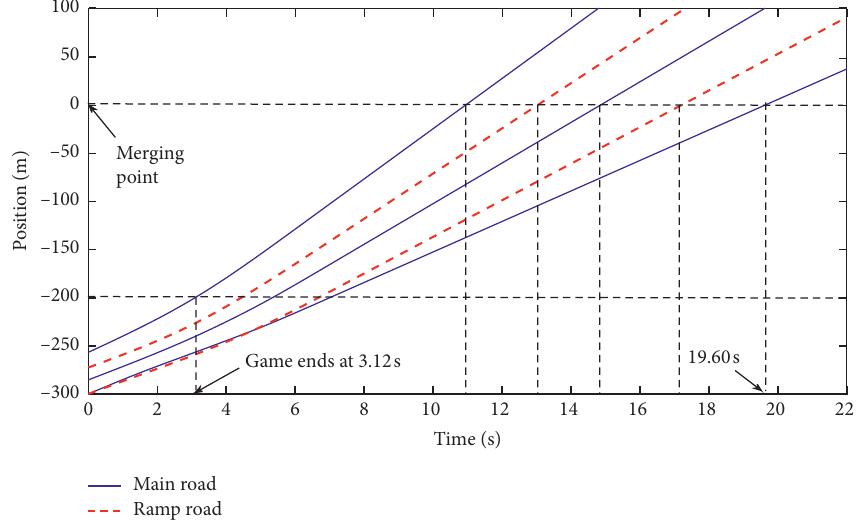
Figure 6: Position of vehicles for Case Study 1.